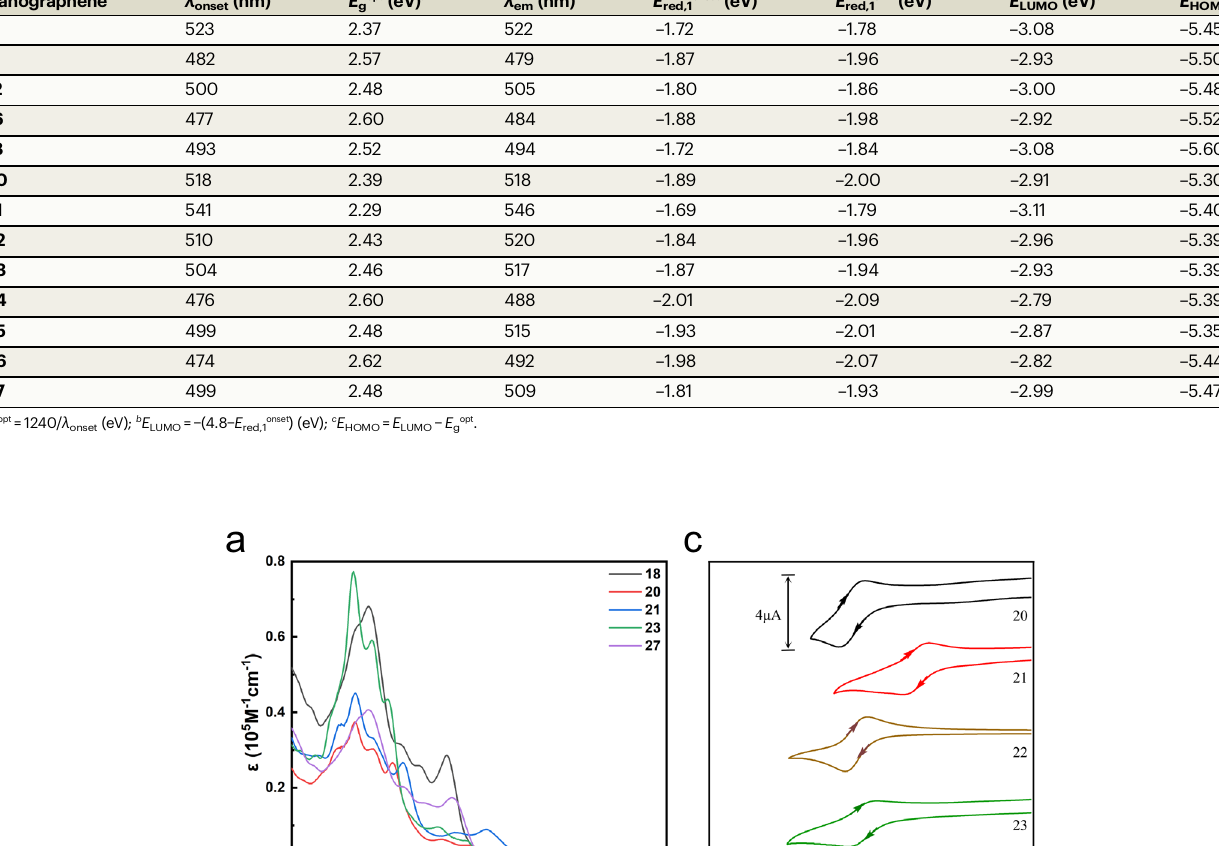
spectra. c Cyclic voltammograms were measured at room temperature in dry, degassed dichloromethane with n -Bu 4 NPF 6 (0.1M) at a scan rate of 0.1Vs − 1 at a 1mm diameter planar glassy carbon electrode under an argon atmosphere (nanographenes 20 , 21 , 22 , 23 , 24 , 25 , 26 , and 27 are represented by black, red, brown, green, teal, blue, magenta, and lavender colored lines,